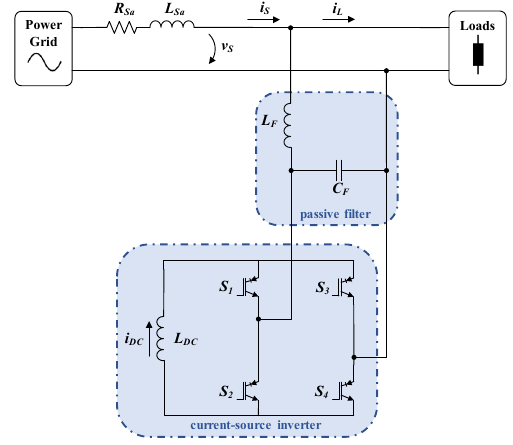
Figure 1. Electrical schematic of the conventional single-phase SAPF based on a current-source